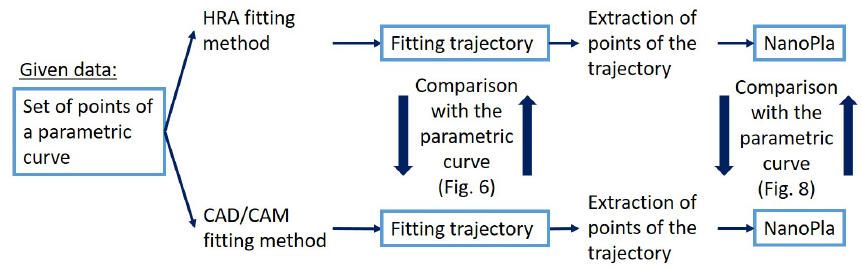
Figure 4. Diagram of the procedure for the analysis of the